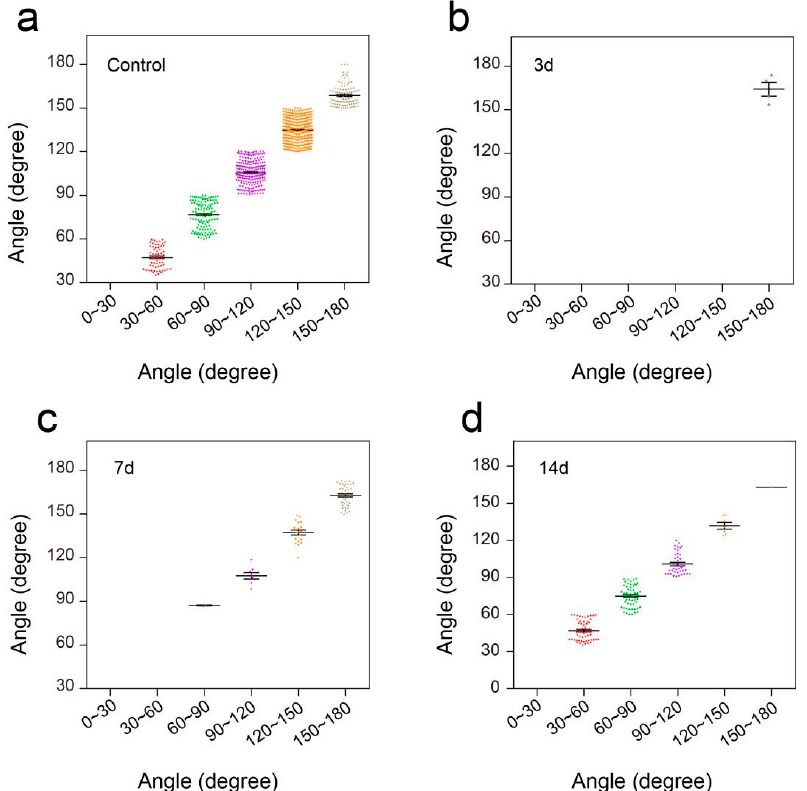
Figure 8. Distribution of ankle angle in open field task. ( a ) Ankle angle distribution of the control group. ( b ) Ankle angle distribution of unilateral thoracic SCI 3d mice. ( c ) Ankle angle distribution of unilateral thoracic SCI 7d mice. ( d ) Ankle angle distribution of unilateral thoracic SCI 14d mice.3.5. Flexible Pressure Sensor was Used to Evaluate the Lower Limb Muscle Movement of Mice in Swimming.